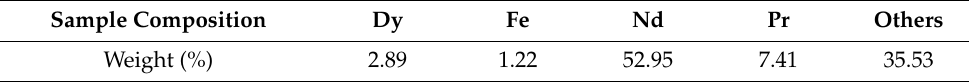
Table 1. The chemical composition of the final product.